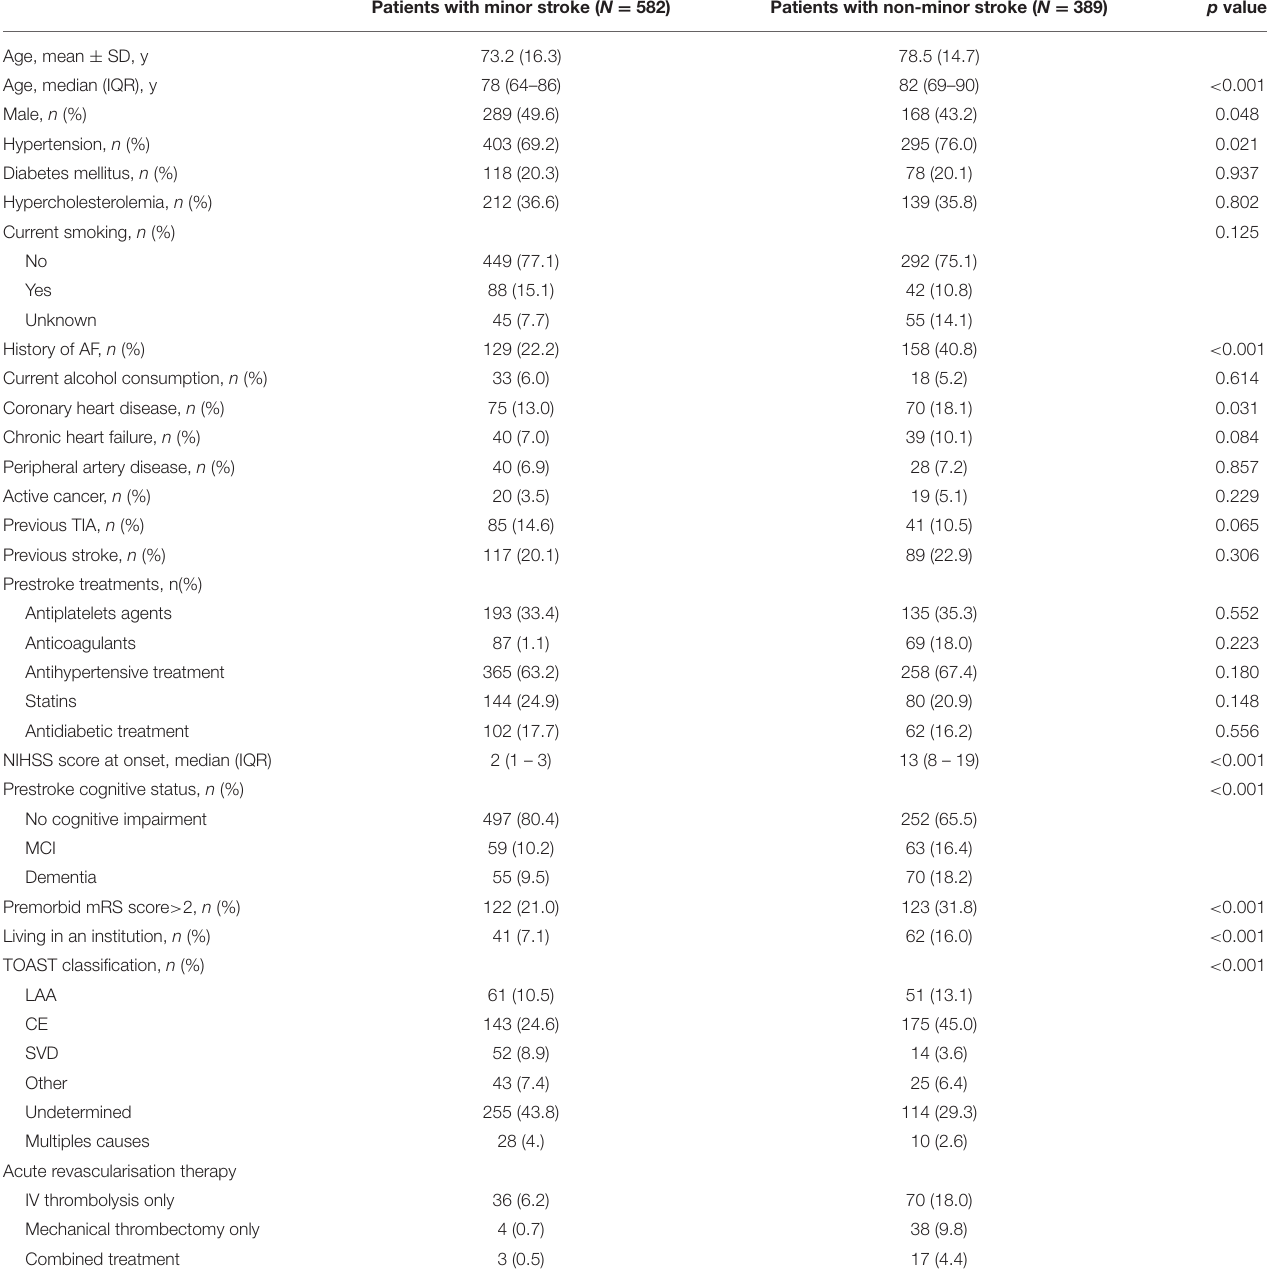
TABLE 1 | Characteristics of patients with minor ( n = 582) vs. non-minor ischemic stroke